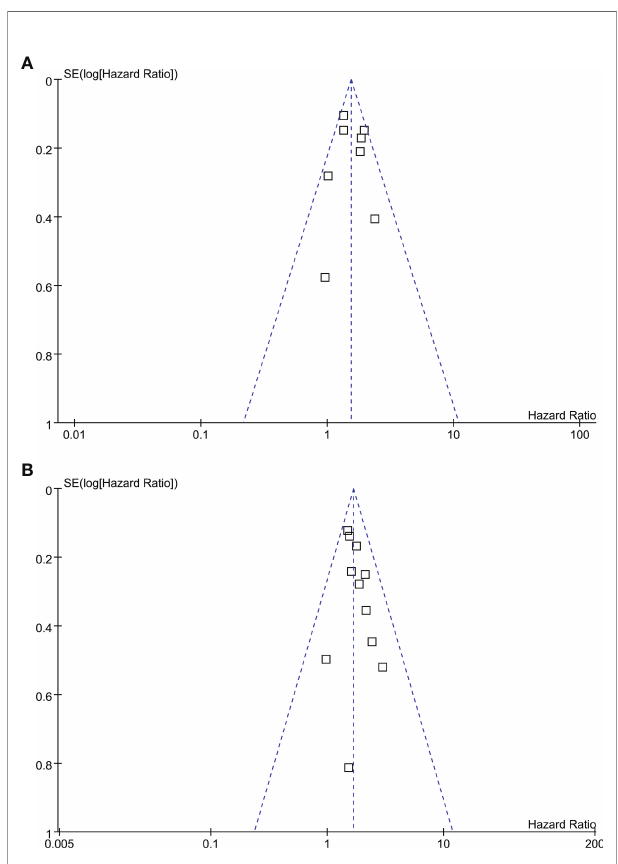
FIGURE 4 | Funnel plots for the publication bias of the meta-analysis of the association between TSR and survival in women with breast cancer; (A) , DFS; and (B) ,